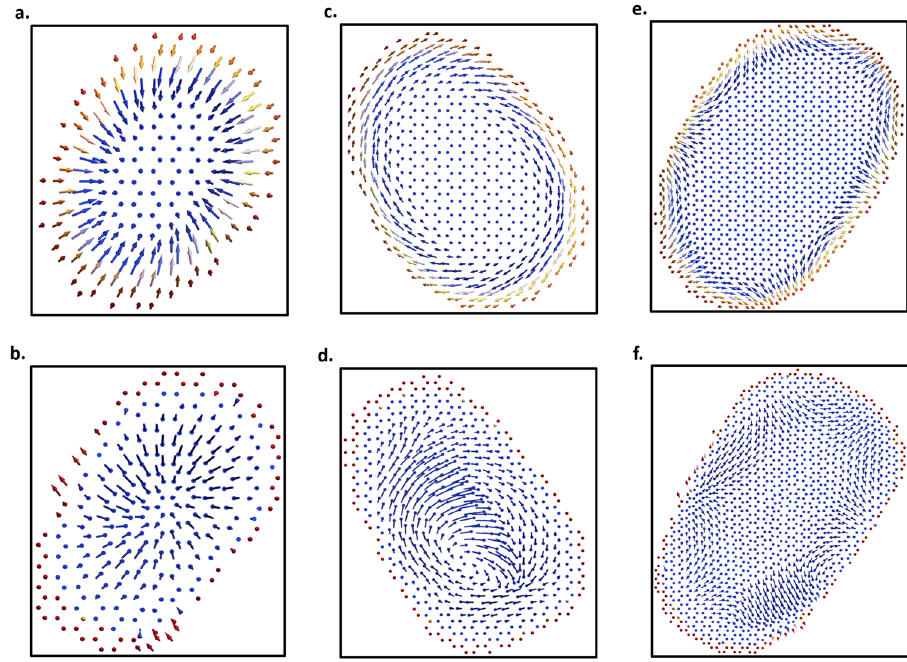
Fig. 2 Multi- fl avor ground state topological spin textures in the nonchiral Heisenberg and Heisenberg-IDMI models. a , b Néel-type skyrmion ( a ) stabilized by an interlayer fi eld with a radial vortex pro fi le ( b ). The skyrmion forms in region III of the Heisenberg model with twist angle θ ¼ 2 (cid:2) and external magnetic fi eld strength B ¼ 1 T . c , d Bloch-type skyrmion ( c ) stabilized by an interlayer fi eld with a sink vortex pro fi le ( d ). The skyrmion forms in region I of the Heisenberg-IDMI model with θ ¼ 1 : 2 (cid:2) and B ¼ 1 : 25 T . e , f Antiskyrmion pair with topological charge Q ¼ 2 ( e ) and the corresponding interlayer fi eld ( f ) in region I of the Heisenberg-IDMI model with θ ¼ 0 : 76 (cid:2) and B ¼ 1 : 5 T . Note that IDMI stands for the intrinsic Dzyaloshinskii – Moriya